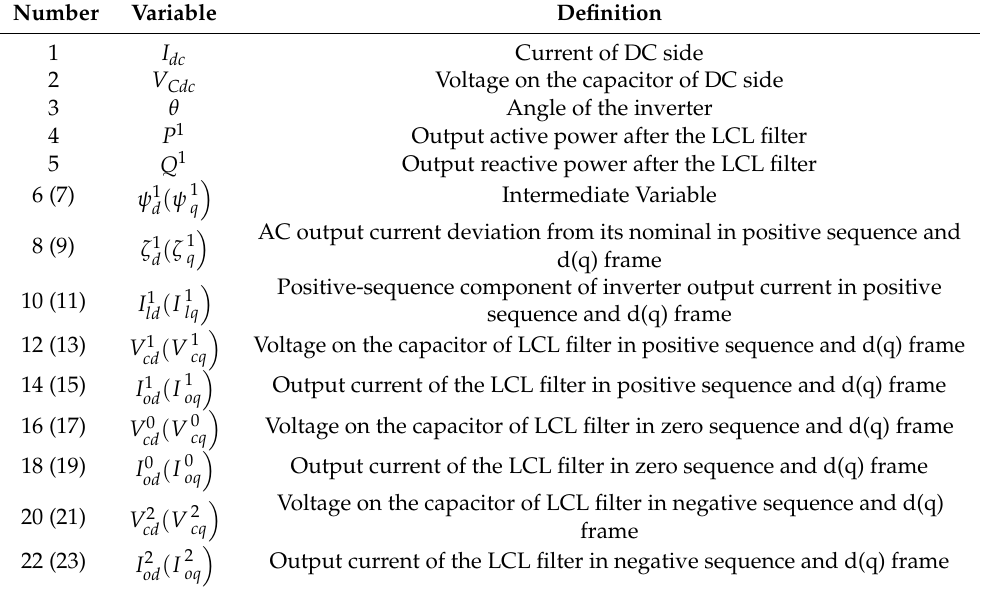
Table 1. Number and definition for each state